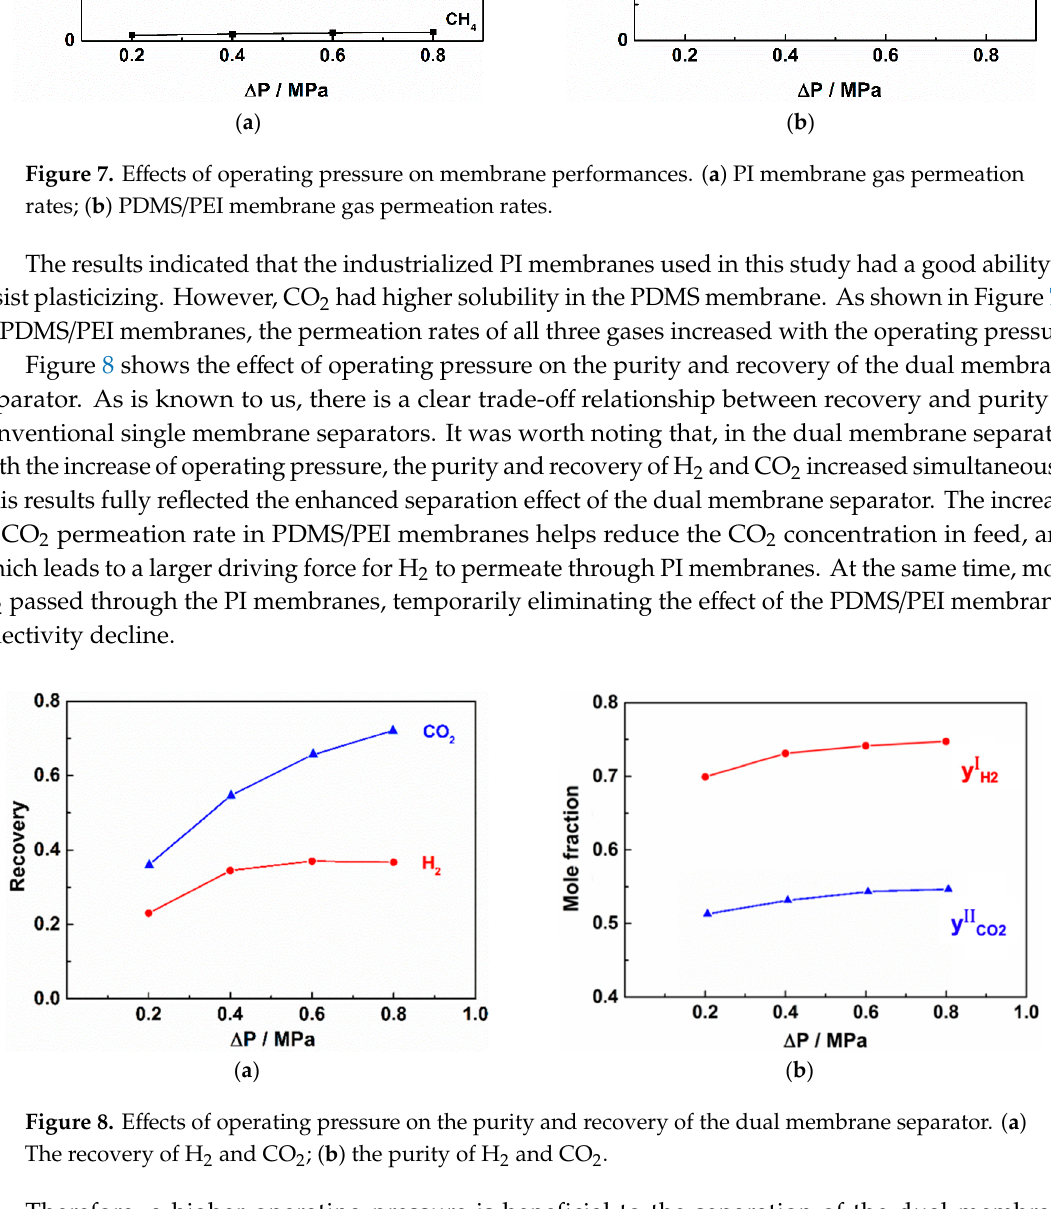
Figure 8. Effects of operating pressure on the purity and recovery of the dual membrane separator. ( a ) The recovery of H 2 and CO 2 ; ( b ) the purity of H 2 and CO 2 .